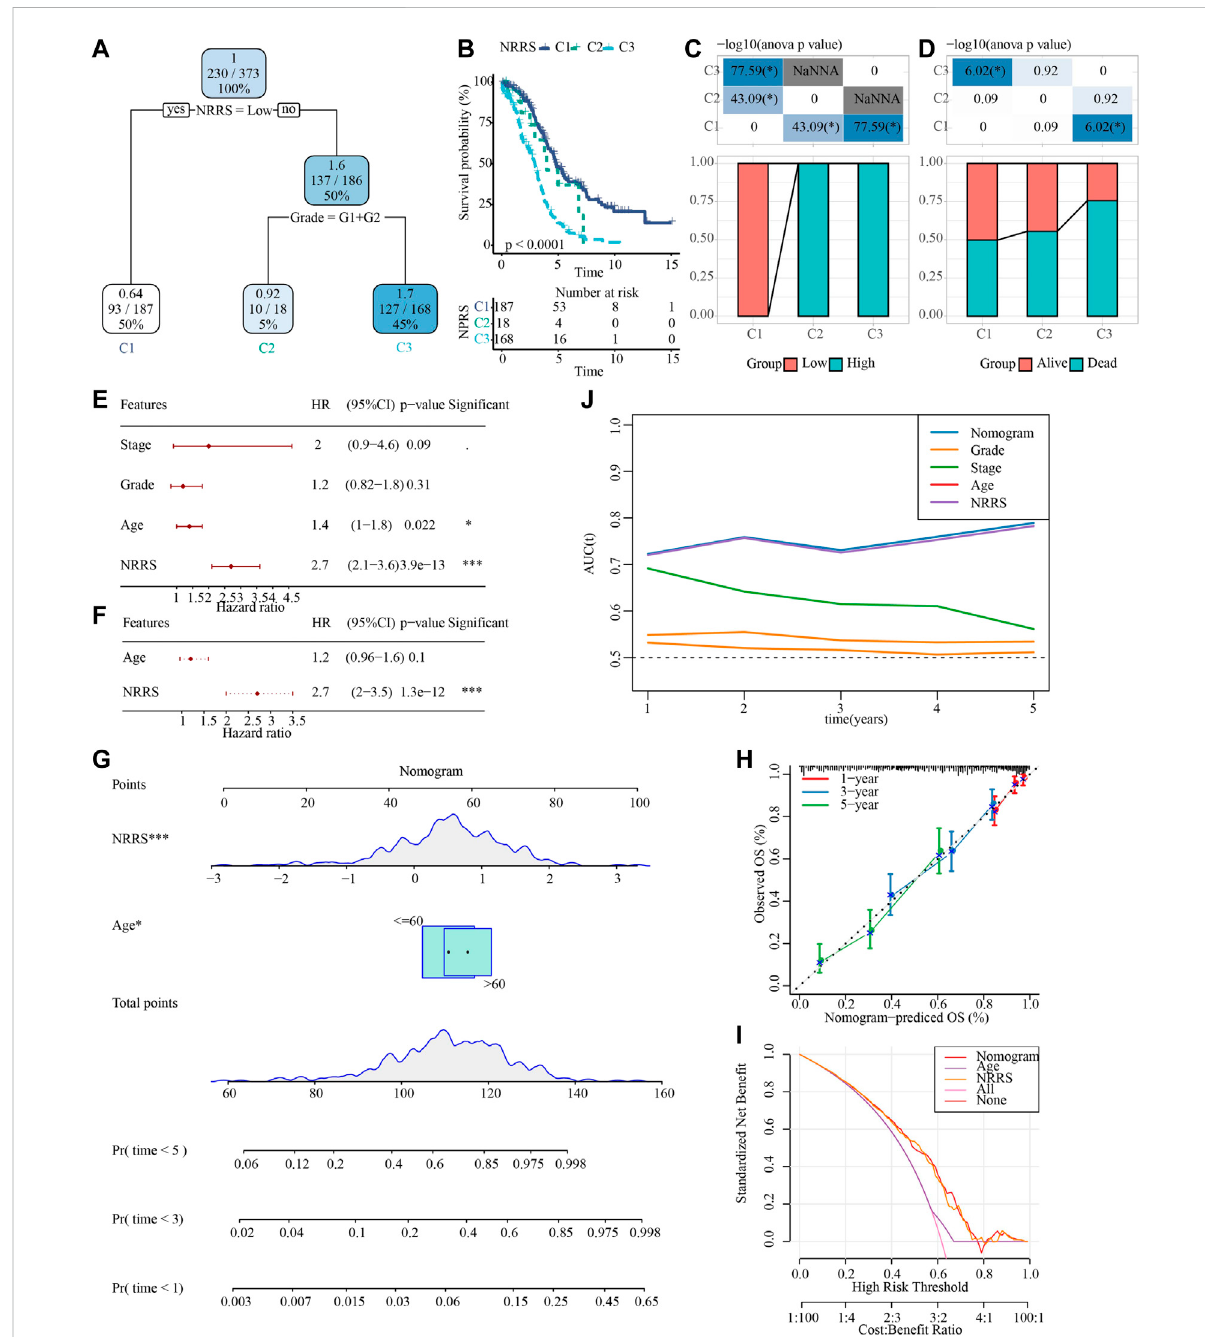
FIGURE 6 Constructionofadecision treemodelandanomogramto improvetheriskstrati fi cationofOSinOVpatients. (A) Decisiontreemodelbasedon NRRSandclinicalfactors(age,stage,grade). (B) Survivalanalysis ofthreerisksubgroupsofthedecision tree. (C) Thedistribution ofNRRSinthreerisk subgroups of the decision tree. (D) The survival status of patients in the three risk subgroups of the decision tree. (E) Univariate Cox regression analysis ofNRRS and clinicalfactorsof OV. (F) Multivariate Cox regressionanalysis ofNRRS andage. (G) The nomogramconstructedaccording toageandNRRS. (H) Thecalibrationcurveevaluatestheproximitybetweenthepredictionlineofthenomogramandtheideal45-degreecalibration line. (I) ThedecisioncurveshowsthenetincomeofNRRSandnomogram. (J) ThetdROCcurvedisplaystheAUCsofNRRSandnomogram.* p < 0.05, *** p <